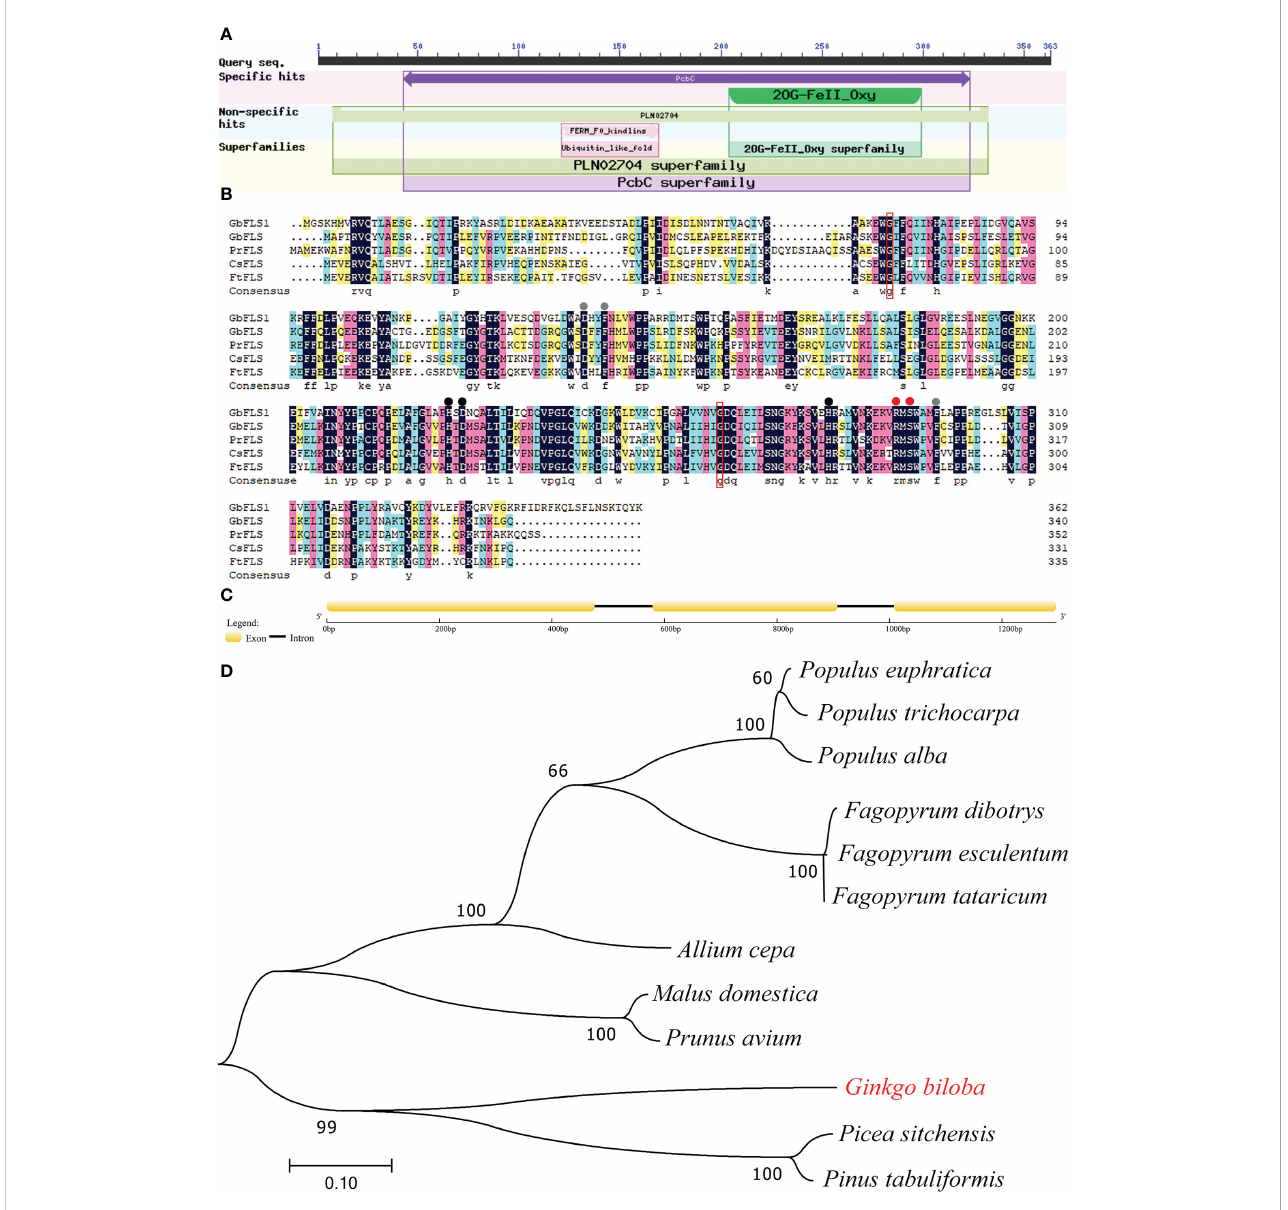
FIGURE 2 Protein domain, multiple alignment, structural features and phylogenetic analysis of GbFLSa. (A) . Protein domain analysis of GbFLSa in ginkgo by NCBI conserved domains. (B) . Multiple alignment of the amino acid sequences of GbFLSa and other fl avonol synthase (FLS) proteins. GbFLS: Ginkgo biloba , ACY00393.1; PrFLS: Pinus radiata , AGY80773.1; CsFLS: Camellia sinensis , ABM88786.1; and FtFLS: Fagopyrum tataricum , AEC33116.1. Red dots show the 2-oxoglutarate-binding residues. The red box indicates the residues responsible for proper folding of the FLS polypeptide. Black dots represent the ferrous iron-binding residues. Gray dots show the putative DHQ-binding residues. (C) Exon – intron structure analysis of the GbFLSa gene. The exons and introns are represented by boxes and lines, respectively. (D) Phylogenetic analysis of GbFLSa and other FLS proteins. The bar indicates a genetic distance of 0.10. GenBank accession numbers are as follows: Populus euphratica (XP_011001283.1), Populus trichocarpa (XP_002325697.1), Populus alba (TKS05742.1), Fagopyrum dibotrys (AHN19765.1), Fagopyrum esculentum (AEC33115.1), Fagopyrum tataricum (AEC33116.1), Allium cepa (AQR58516.1), Malus domestica (XP_028949987.1), Prunus avium (XP_021810338.1), Picea sitchensis (ABK26270.1), and Pinus tabuliformis